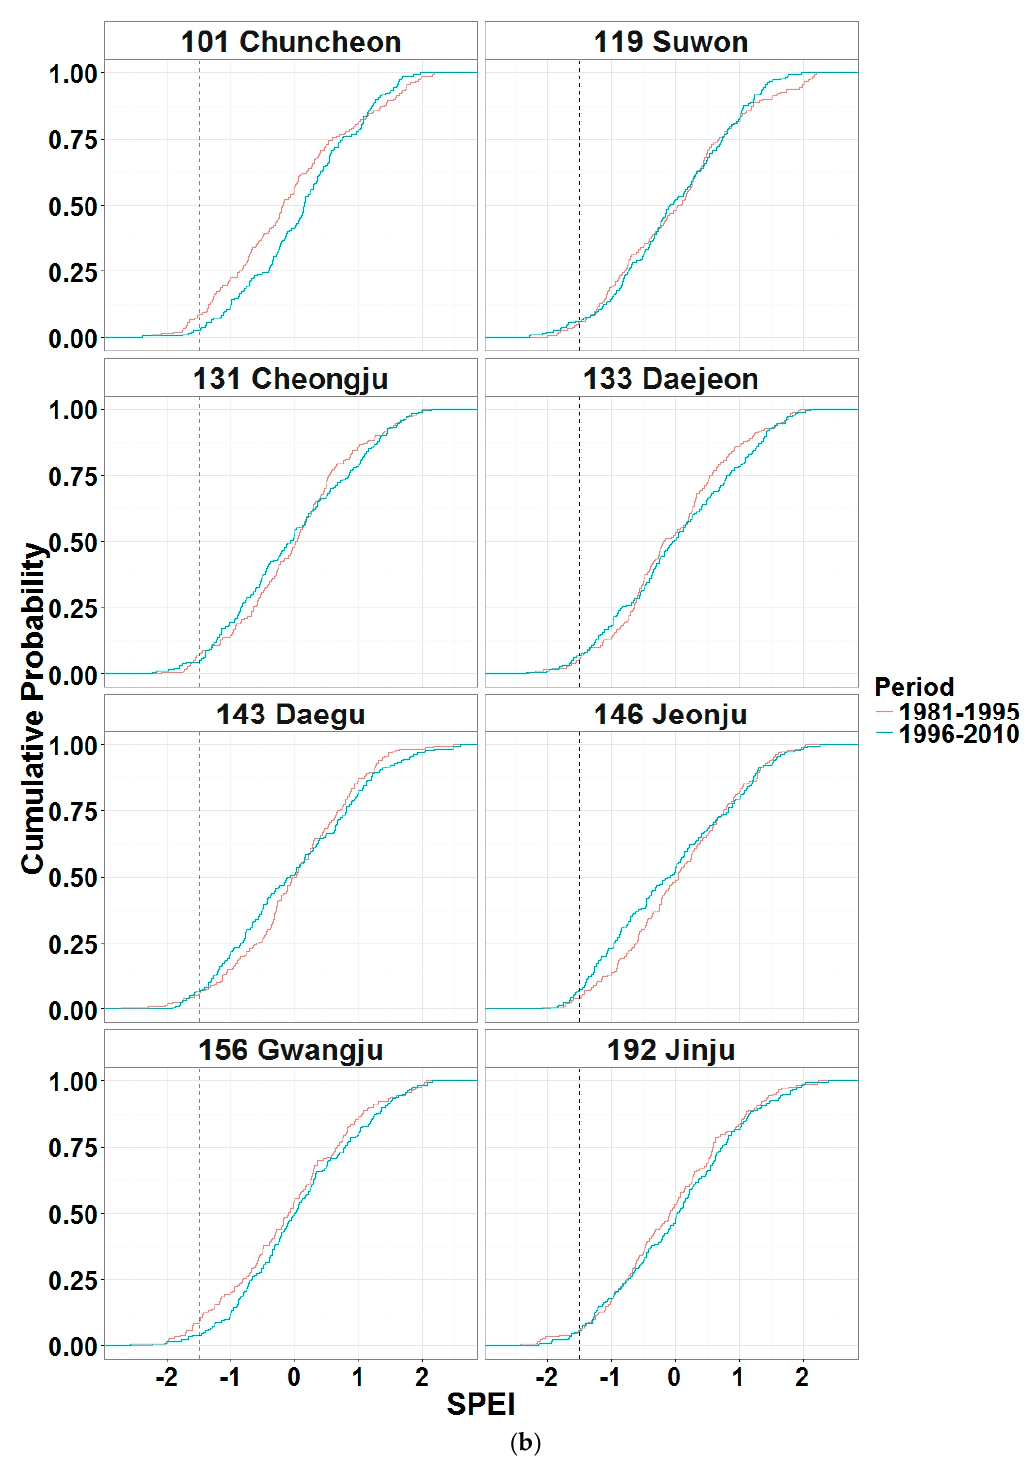
Figure 5. Cumulative probability curves of 1- and 3-month SPEI_pm for different regions. ( a ) 1-month SPEI_pm, ( b ) 3-month SPEI_pm.